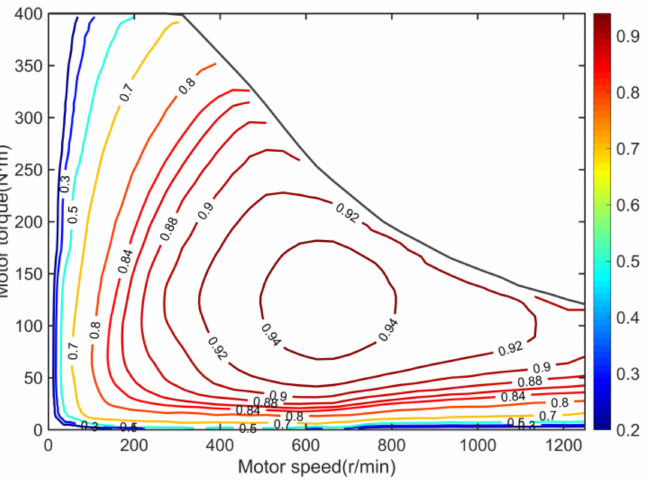
Figure 4. Motor efficiency